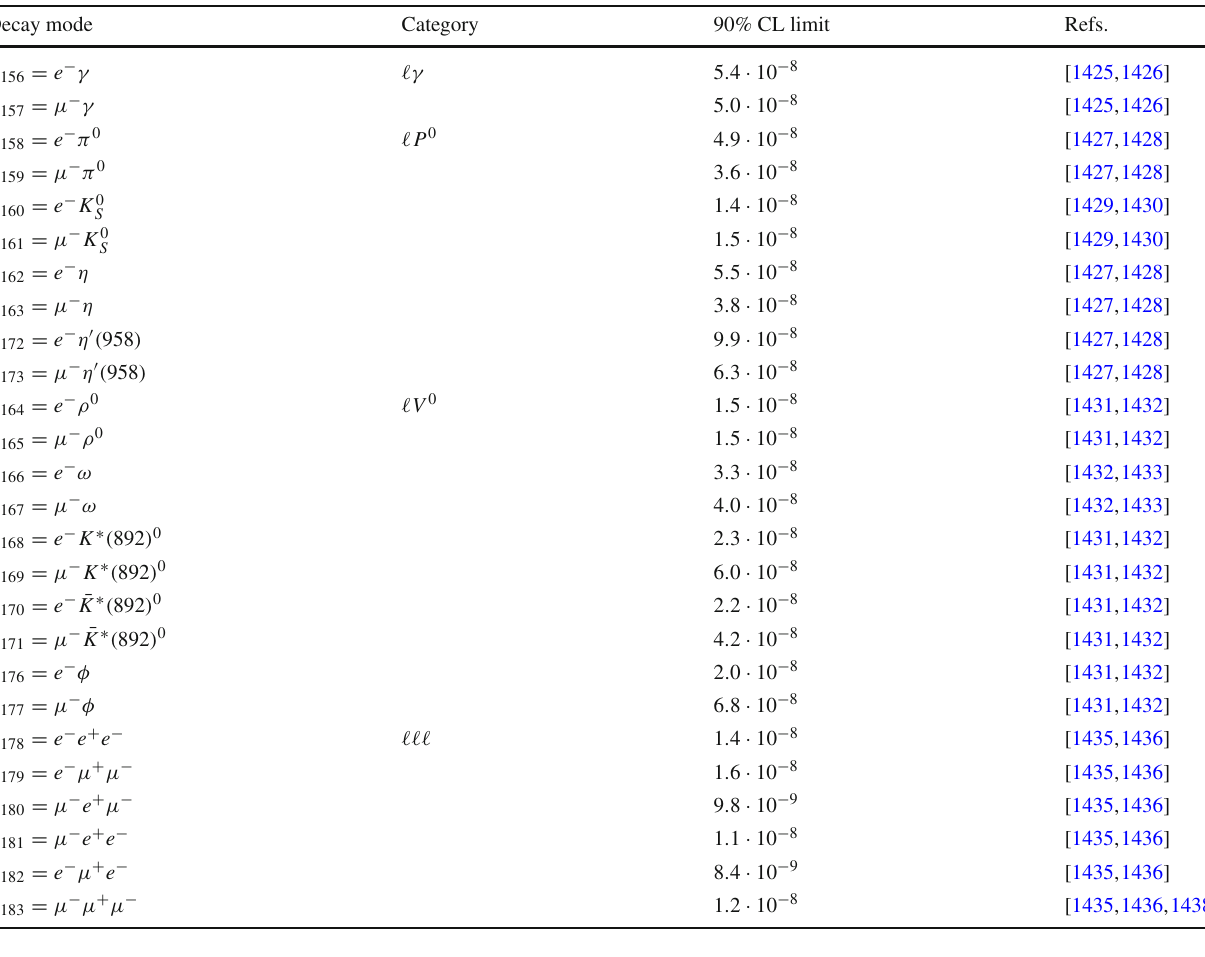
Table 318 Combinations of upper limits on lepton flavour violating τ decay modes. The modes are grouped according to the properties of their final states. Modes with baryon number violation are labelled with “BNV” Decay mode Category 90% CL limit